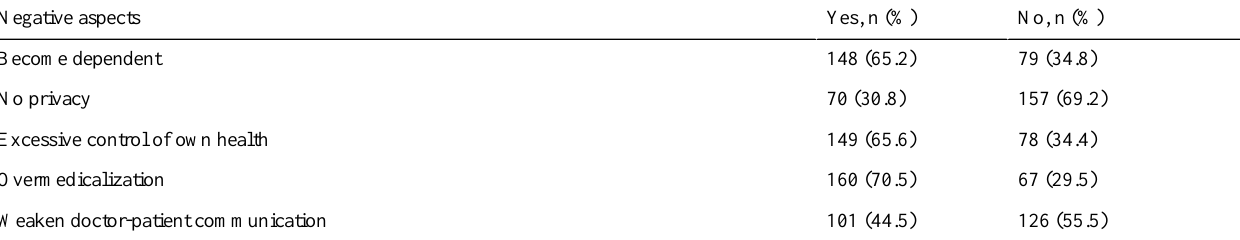
Table 6. Negative aspects of constant adoption of health apps and wearable devices